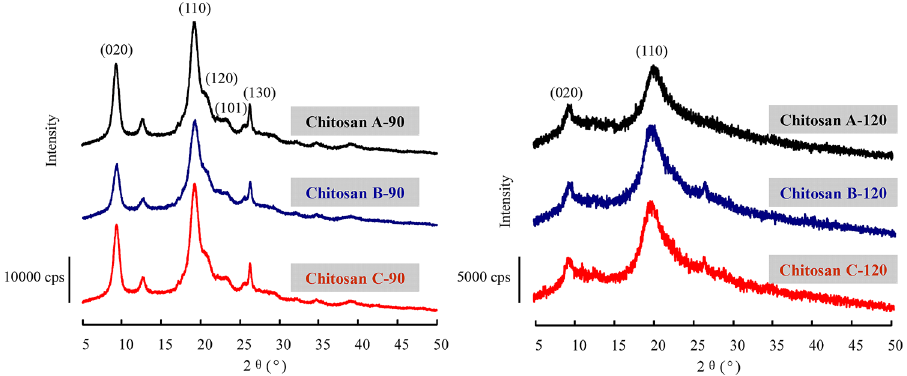
Figure 3. XRD patterns of crab shell chitosan by deacetylation at 90 °C and 120 °C.